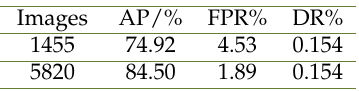
Table 2. Data enhanced experimental comparison.